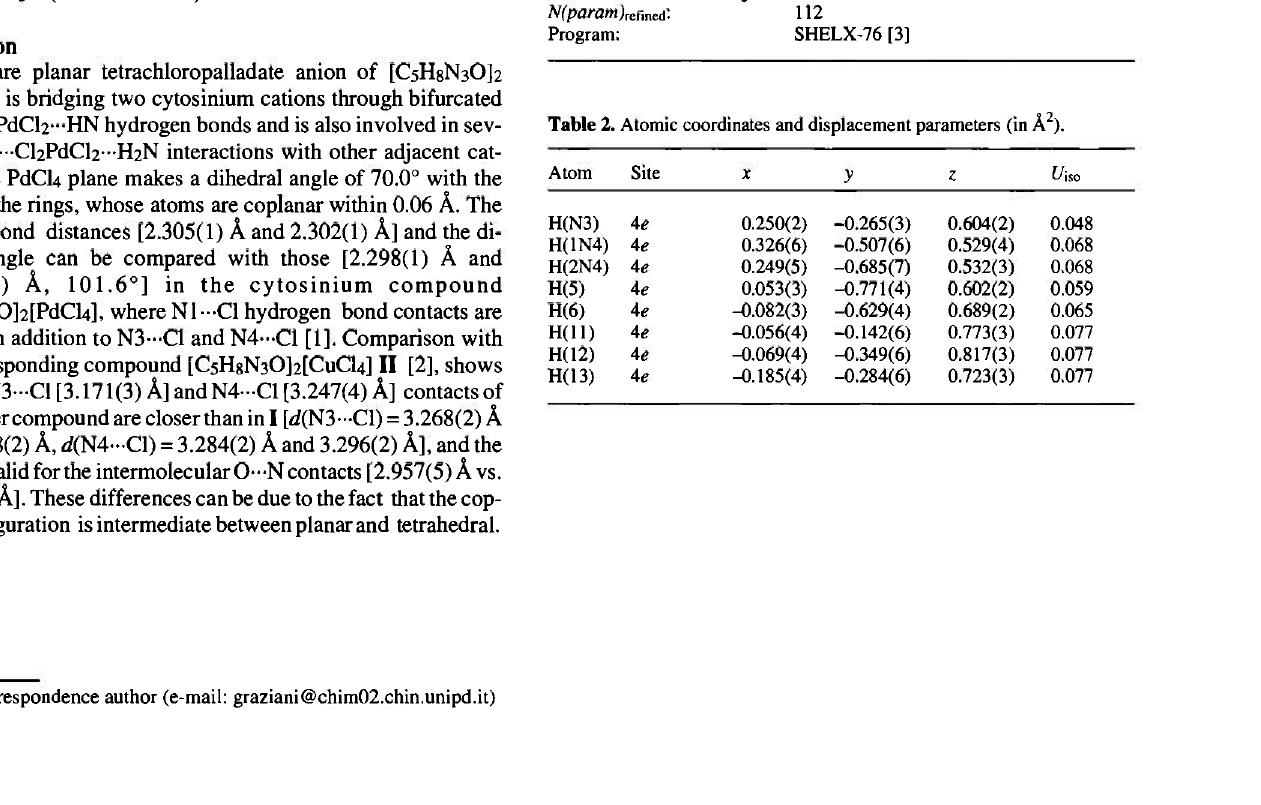
Table 1. Data collection and handling.